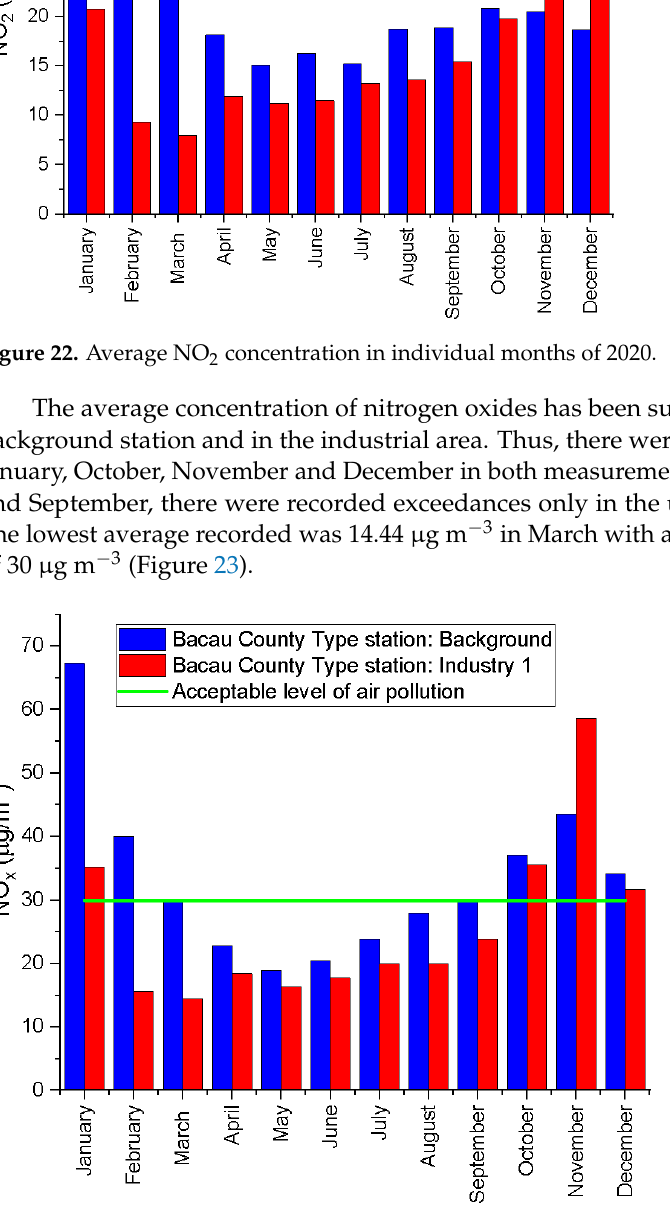
Figure 24. Average SO 2 concentration in individual months of 2020.